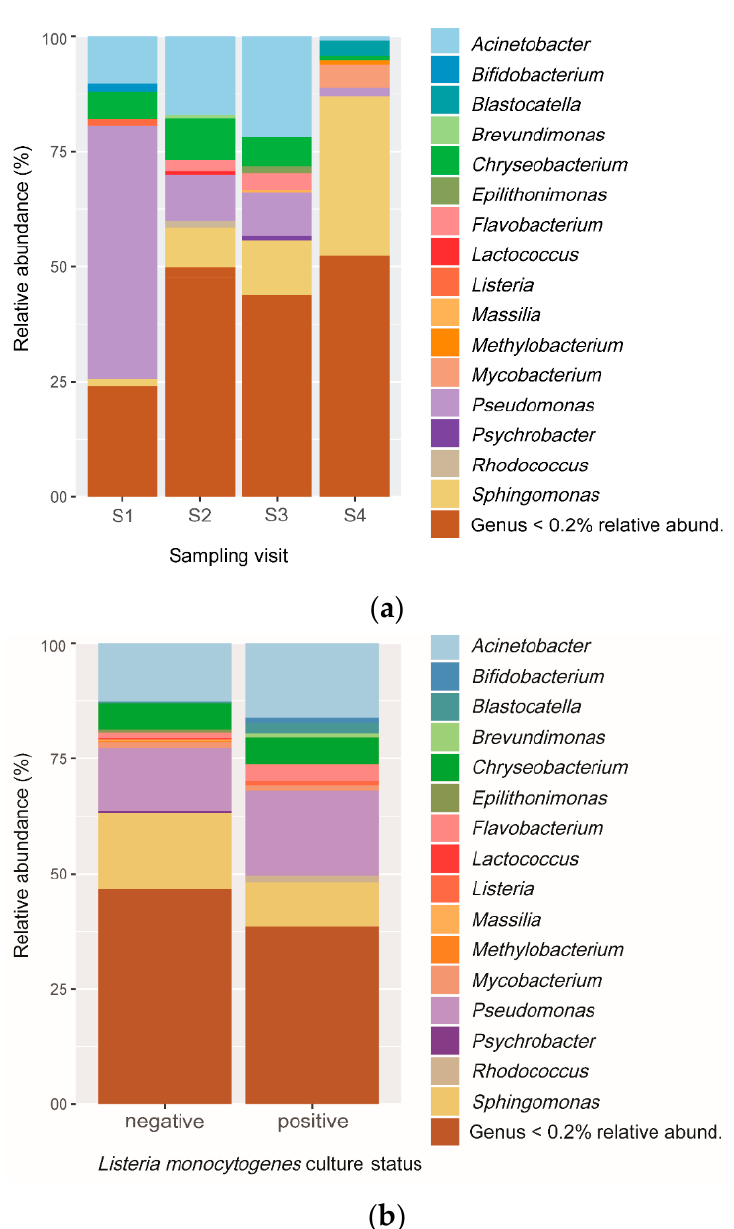
Figure 3. Relative frequency of different taxonomic profiles identified from OTUs in cutting facility conveyor surfaces. ( a ) Relative abundance of the top sixteen genera according to the sampling periods. ( b ) Relative abundance of the top sixteen genera according to L. monocytogenes culture results.